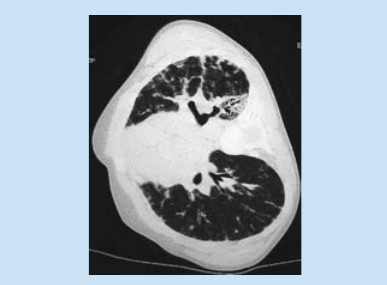
Fig. 8. Air-trapping in ‘side down’lung.